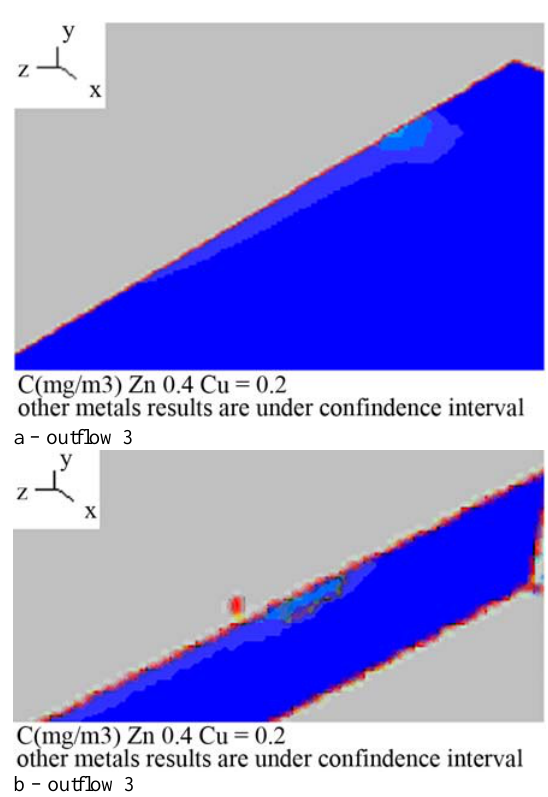
Fig. 7. Heavy metals spread from outflow with minimum concentration: a – river surface, b – river depth